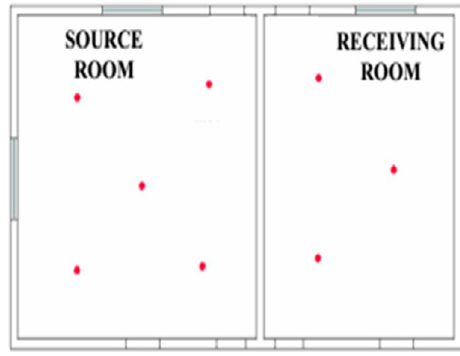
Fig. 2. Adjacent rooms and red point refer to the microphone